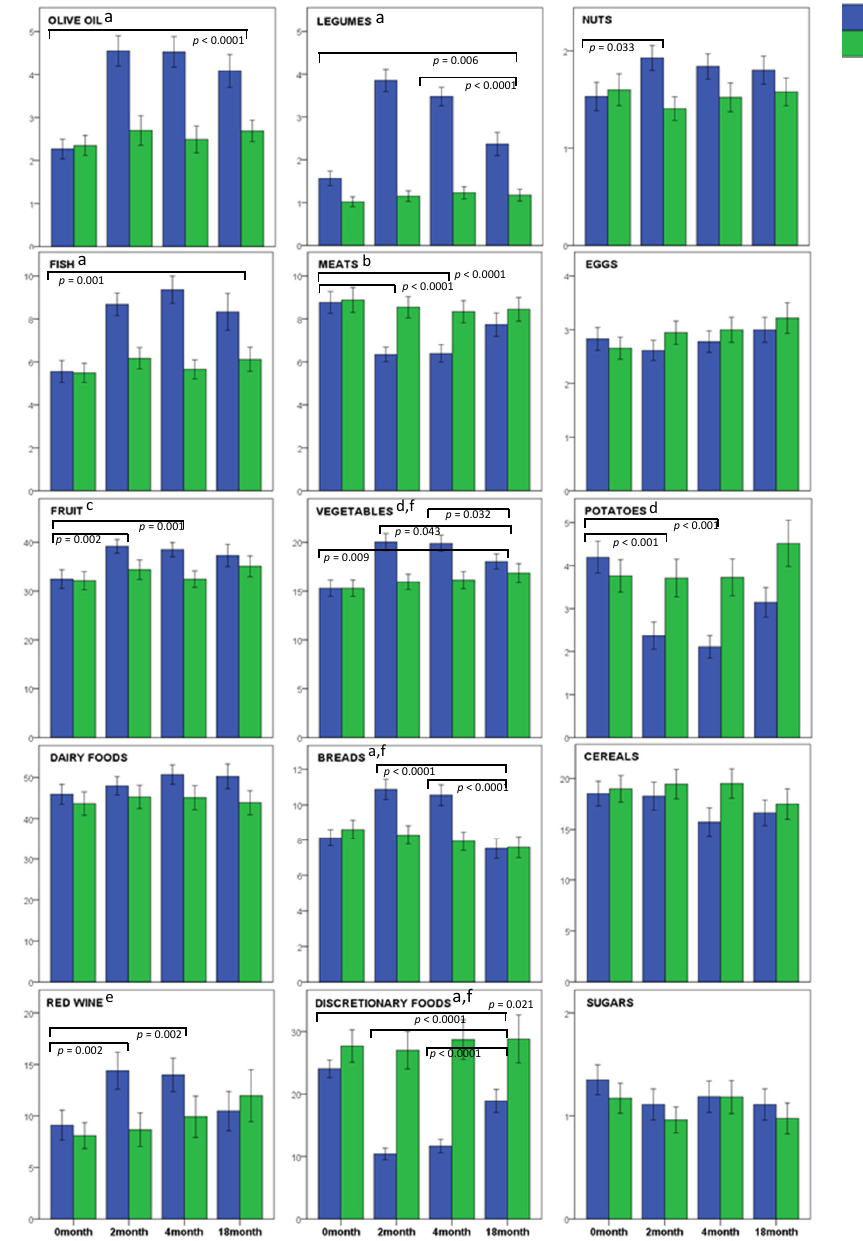
Figure 3. Mean intake of foods for each dietary group over 18-months presented as g/MJ/day.